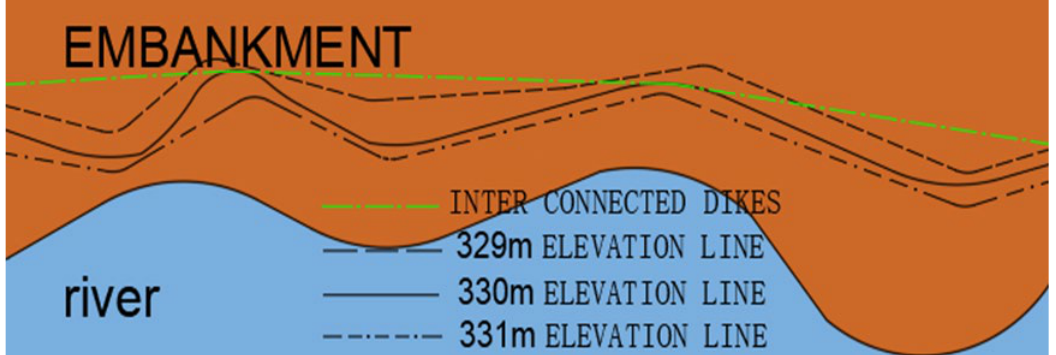
Figure 6. Embankment building scheme (north bank).